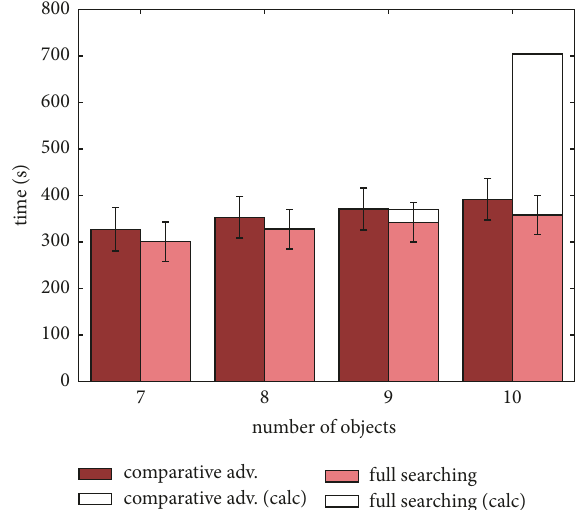
Figure 11: Makespan and calculation time in 100 simulations. There are 7, 8, 9, and 10 objects.